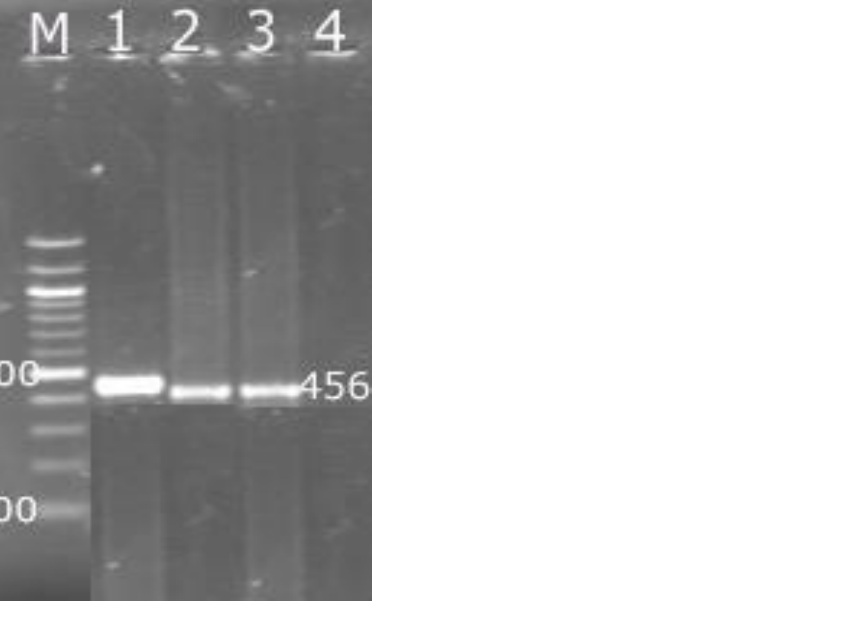
Table 3. Count (log cfu g −1 ) and percentage reduction of L. monocytogenes inoculated in manufac- tured soft cheese with Bifidobacterium spp. stored at 4 ± 2 °C.